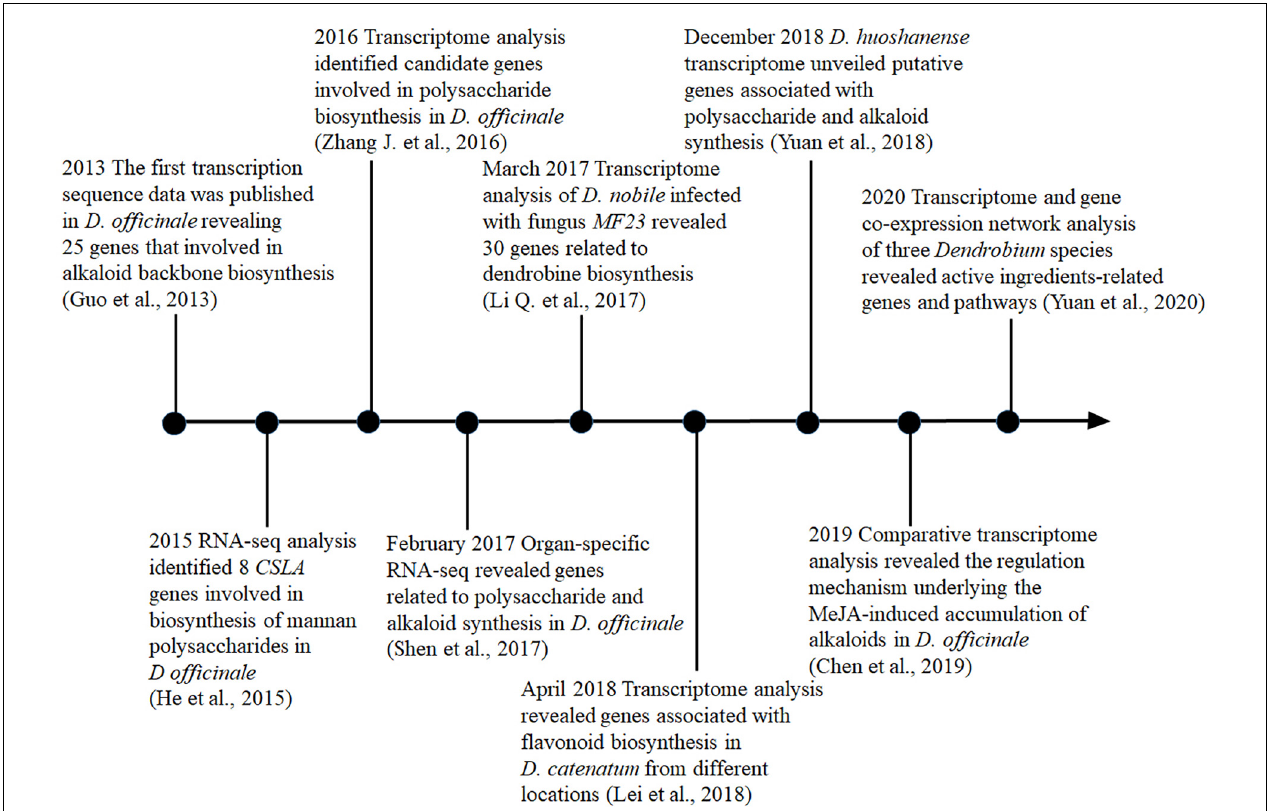
FIGURE 1 | Timeline of transcriptome studies probing the biosynthesis pathways for active ingredients in medicinal Dendrobium . Notable studies were included and the key references for each study were